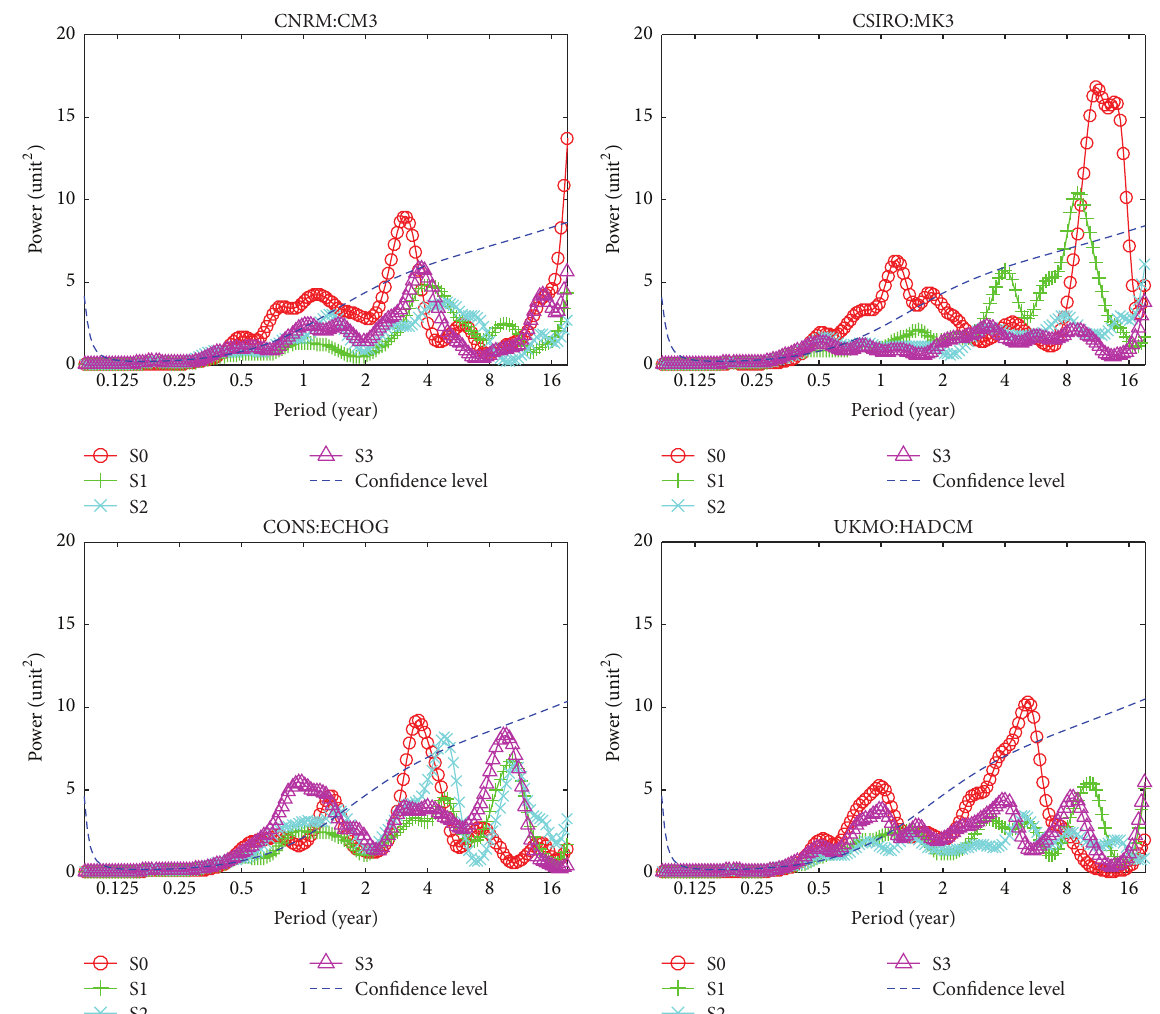
Figure 6: A comparison of global wavelet spectra for the Geum River watershed (S0: 1976 ∼ 2010, S1: 2011–2040, S2: 2041–2070, and S3: 2071– 2099). The dashed blue line is the significance for the global wavelet spectrum, assuming the same significance level and background spectrum as in wavelet power spectra. All analyses employed the Morlet